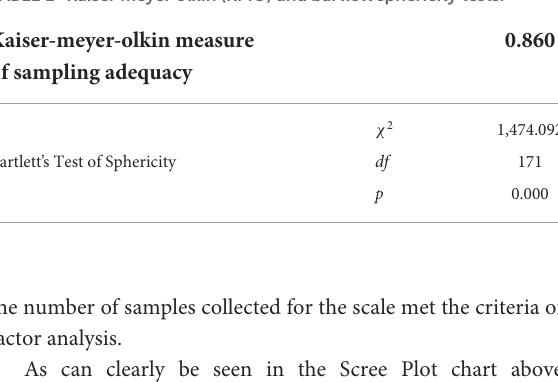
TABLE 1 Kaiser meyer olkin (KMO) and bartlett sphericity